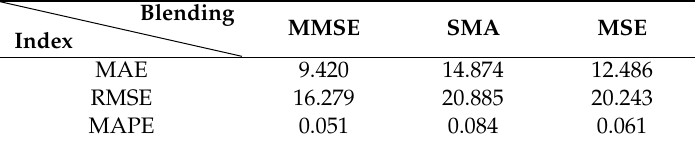
Table 3. Evaluation of blending technique using rain gauge data.